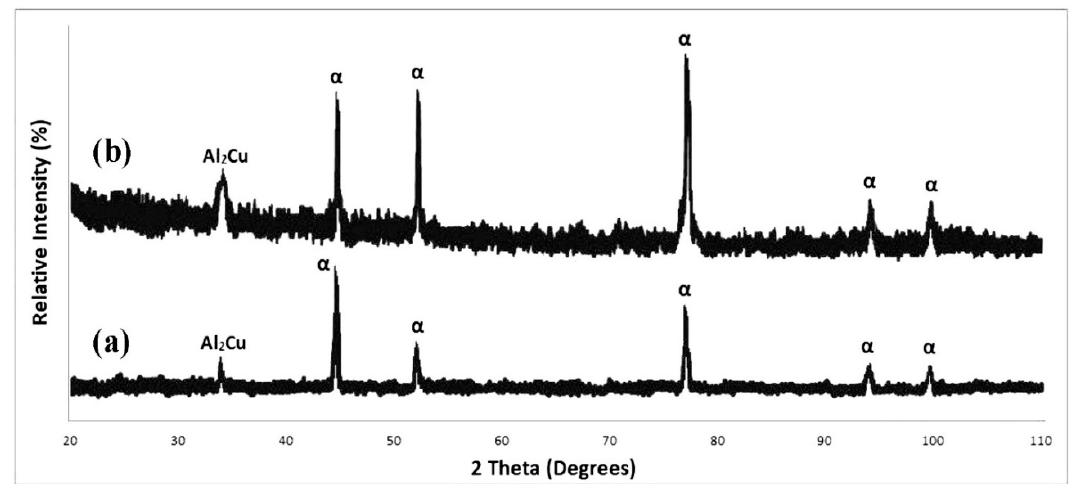
Figure 13. XRD analysis of AA1100 aluminium plate, before and after FSW processing by the square-shape pin tool; ( a ) parent metal and ( b ) stirring zone.